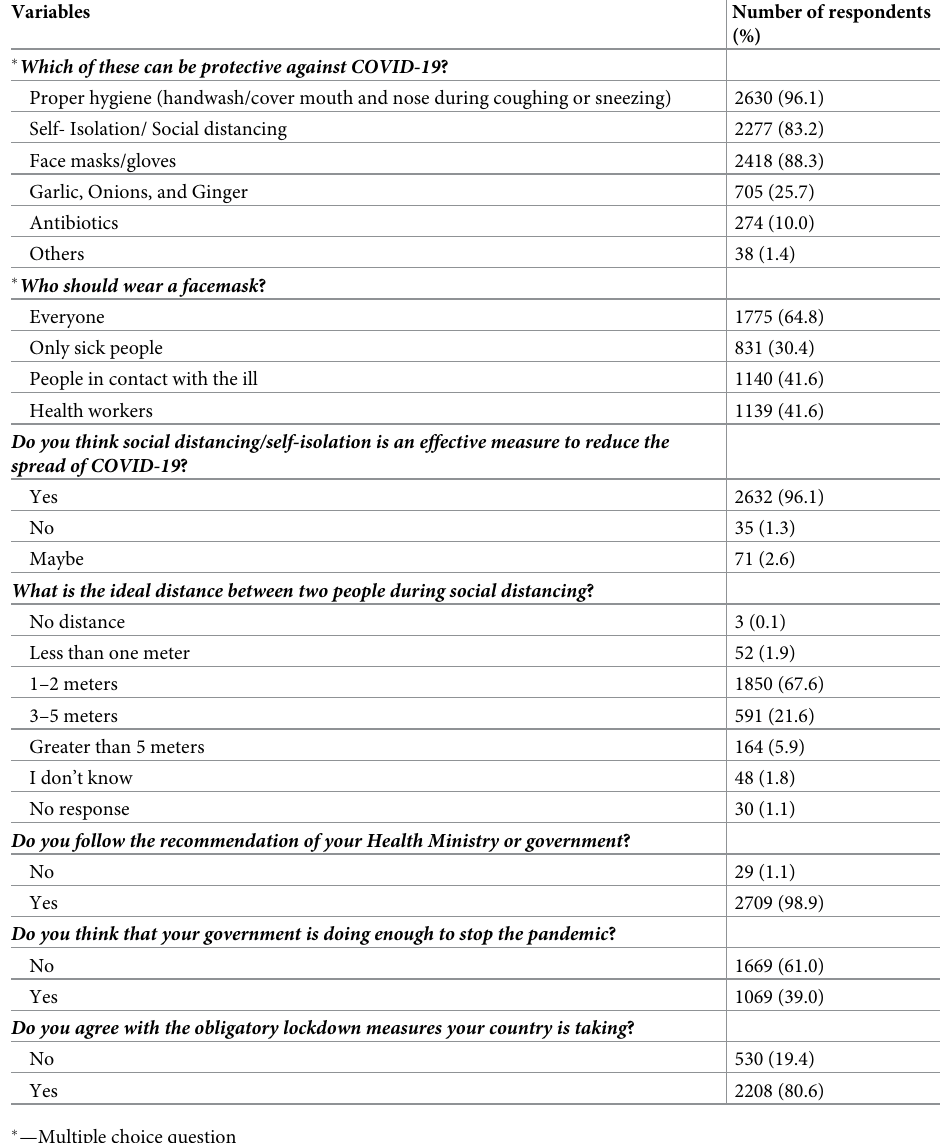
Table 5. Descriptive statistics of respondents’ attitudes to the COVID-19 pandemic in the three regions. Variables Number of respondents